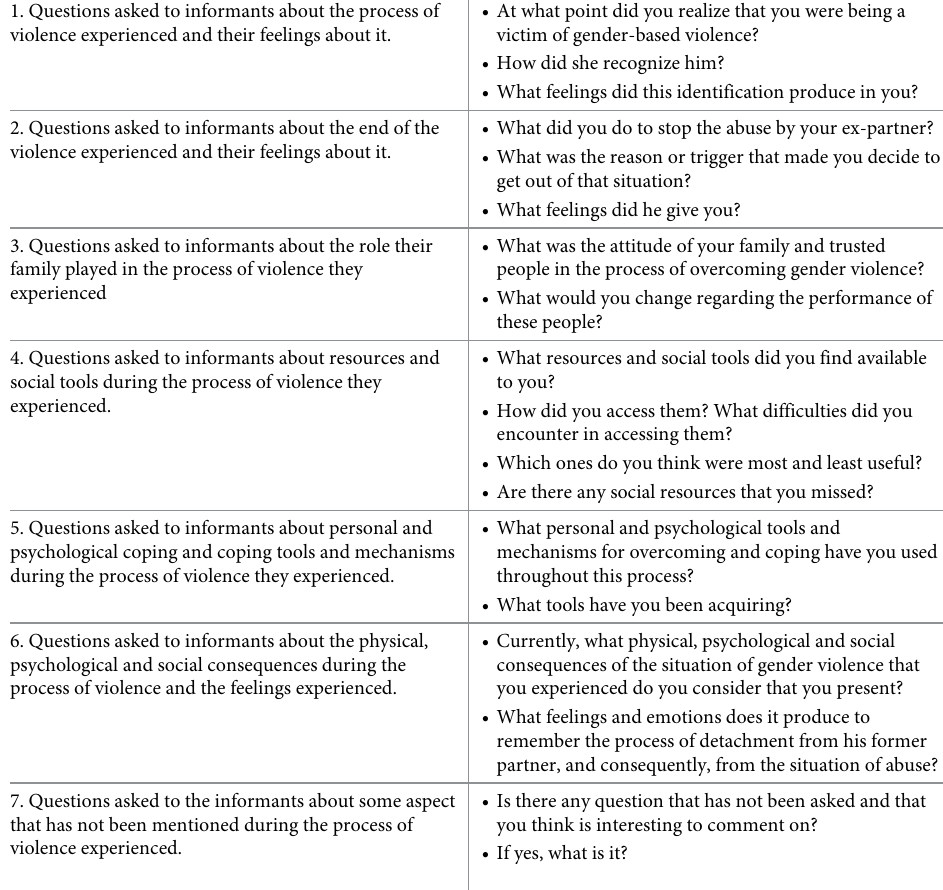
Table 1. Questions asked to informants during the process of lived